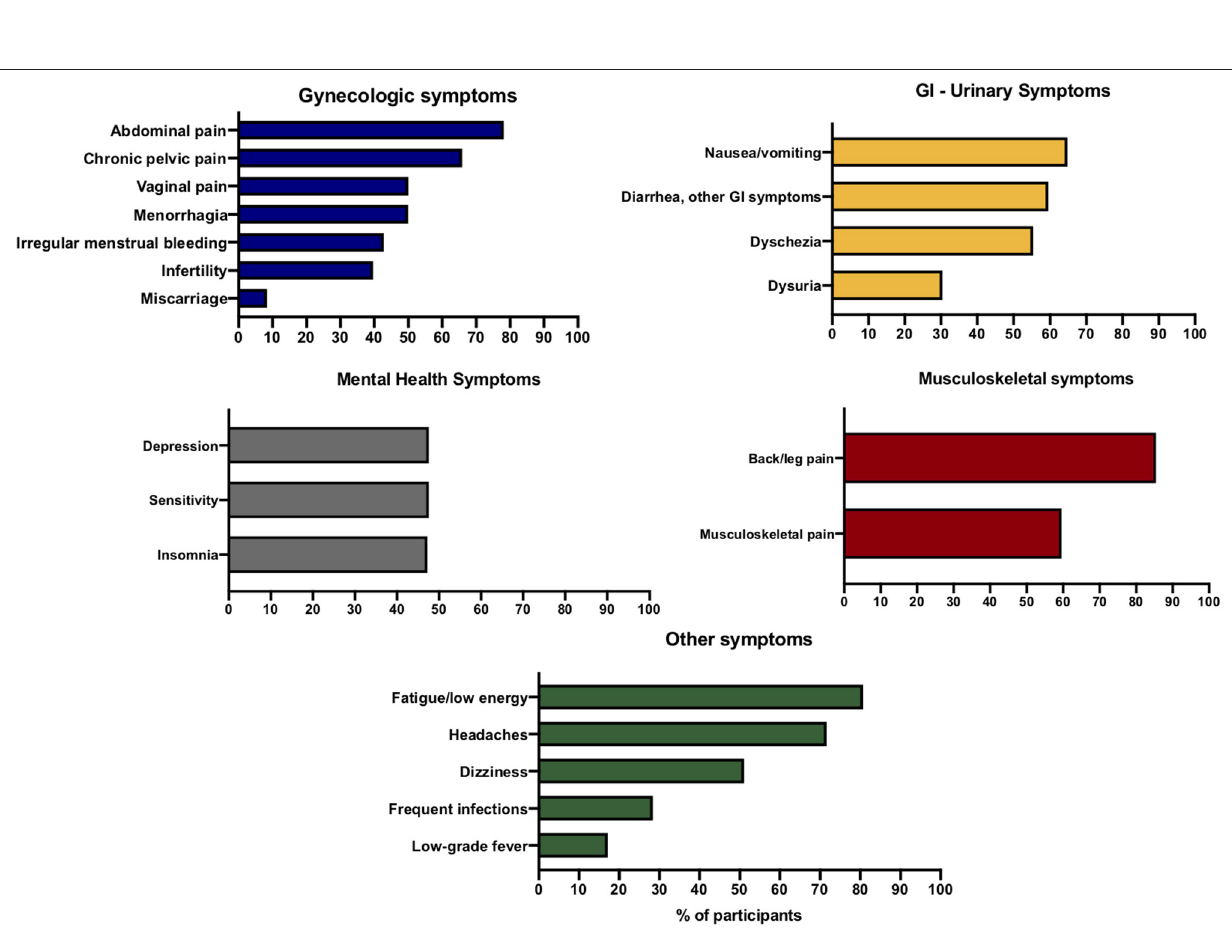
Frontiers in Reproductive Health | www.frontiersin.org